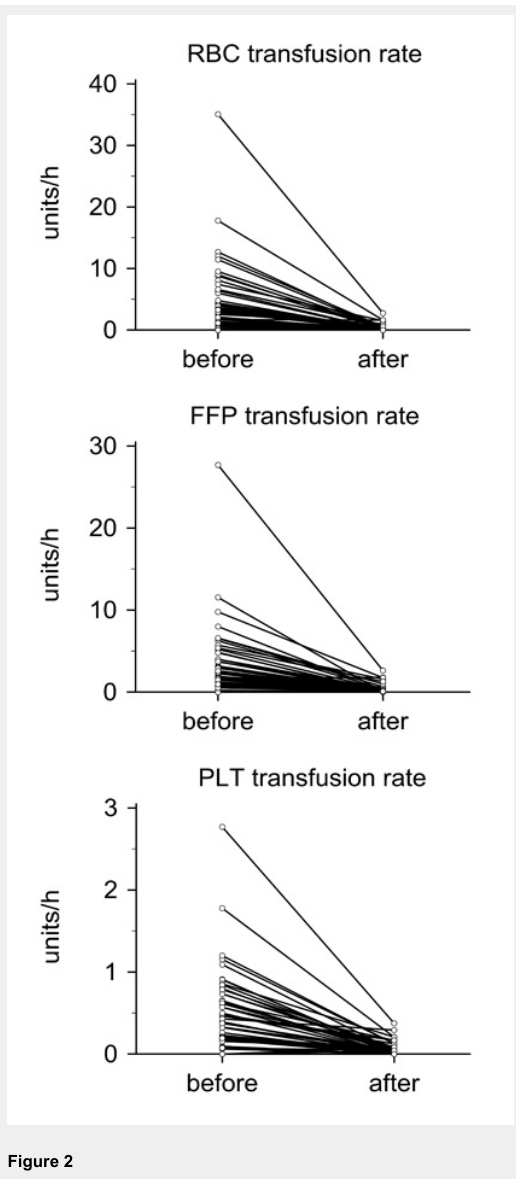
Figure 2 Transfusion requirement before and after rFVIIa. Change in transfusion rates of packed red blood cells (RBC), fresh frozen plasma (FFP), and platelet concentrates (PLT) from a time window of 4.9 hours (median; range: 2.5– 8.8) before administration of rFVIIa compared to 24 hours thereafter for patients living more than one day after treatment (n =